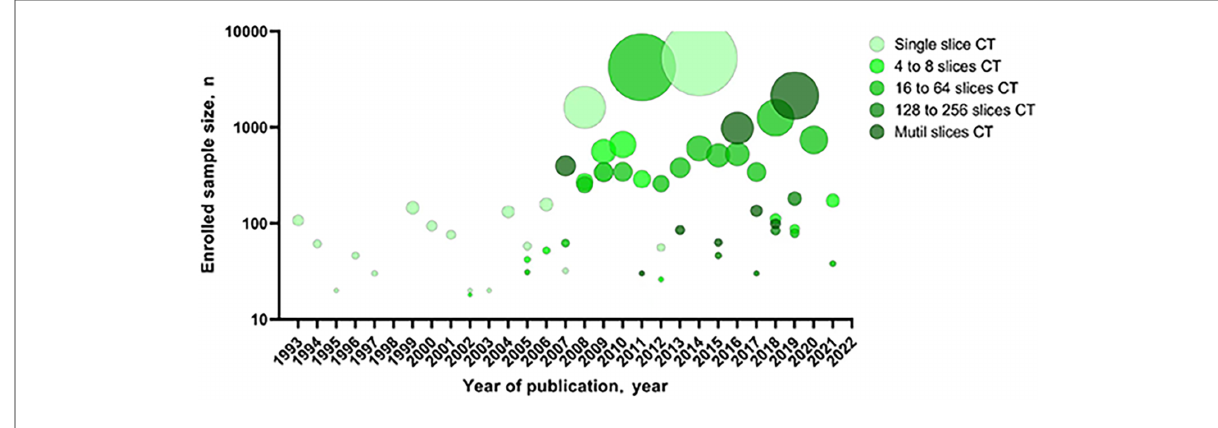
FIGURE 2 Sample size of the articles included in the systematic review by year of publication and MDCT. MDCT, multi-detector computed